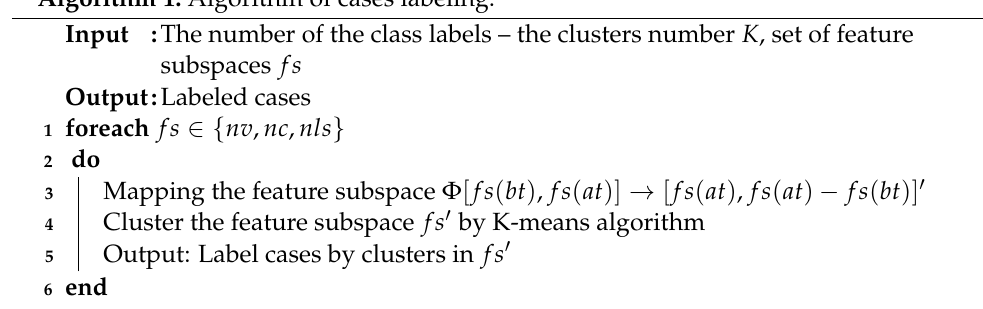
Algorithm 1: Algorithm of cases labeling.